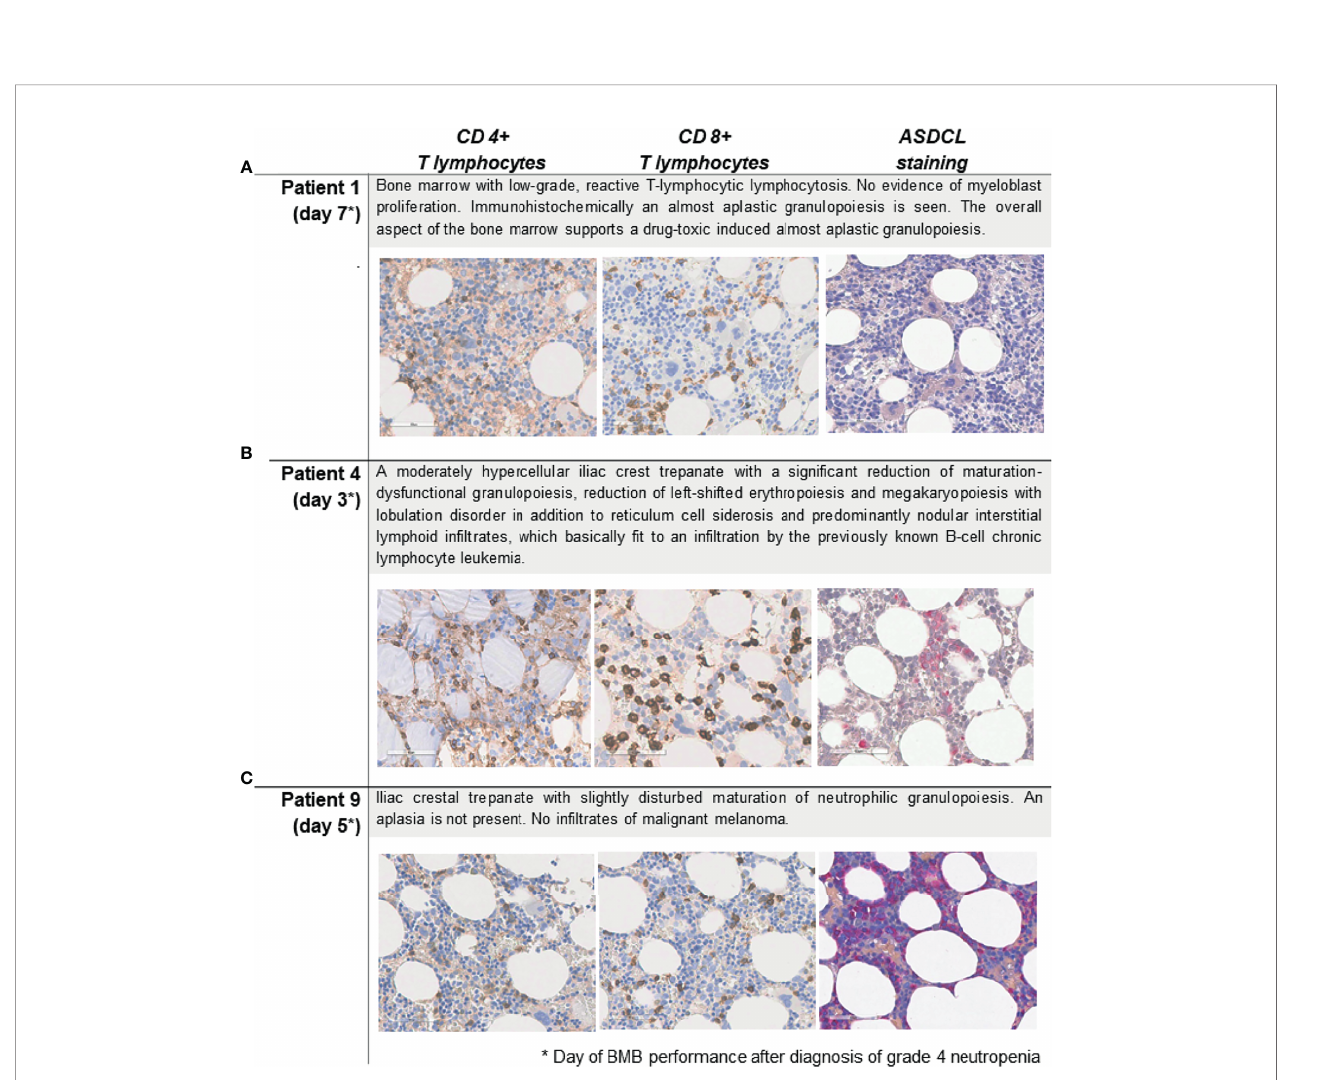
FIGURE 1 | Bone marrow staining for CD4+ T and CD8+ T lymphocytes, and naphthol AS-D chloroacetate esterase (ASDCL) staining for myeloid cells in patients with ICI-induced grade 4 irNeutropenia (n=3). (A) Patient 1, (B) Patient 4, (C) Patient 9. Original magni fi cation 400×. BMB, bone marrow biopsy; CD, cluster of